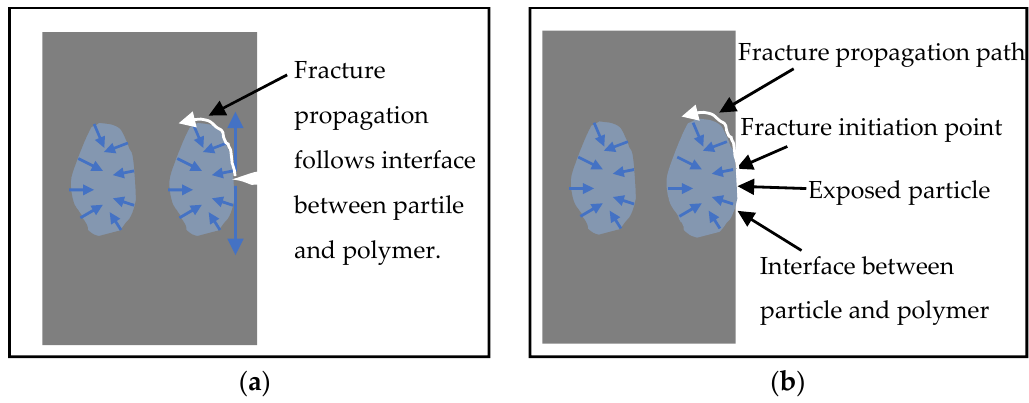
Figure 8. A schematic description of fracture propagation in notched Izod impact test ( a ) and fracture initiation in unnotched Izod impact test ( b ).